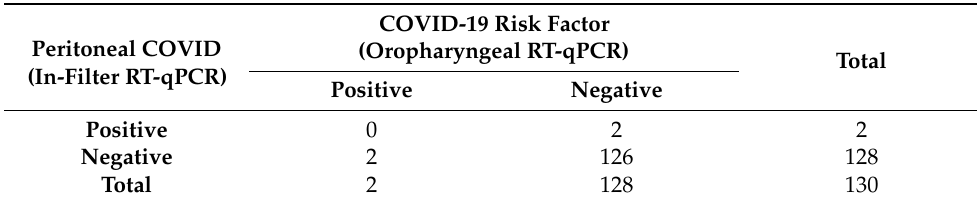
Table 1. Two-by-two table between the risk factor (oropharyngeal RT-qPCR) and peritoneal disease (RT-qPCR in-filters